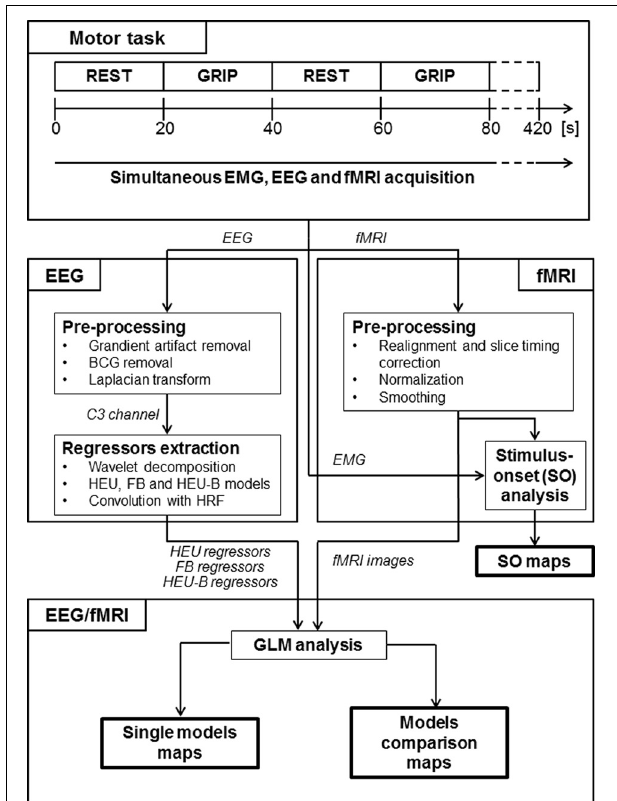
FIGURE 1 | Experimental protocol and data analysis pipeline. This figure gives a schematic overview of the task, the different steps in EEG-fMRI processing and the outcome of the analysis (see Methods section for details). “Motor task” block: the motor task consists in a block-designed right hand grip. “EEG” block: gradient and BCG artifacts were removed from the EEG data; a surface Laplacian estimation was applied; EEG from channel C3 was decomposed using wavelet transform and HEU, FB and HEU-B regressors were estimated. “fMRI” block: the EPI images were motion and slice timing corrected, normalized and spatially smoothed; regressors modeling motor task were created and a stimulus-onset group map was obtained through GLM analysis. “EEG/fMRI” block: the HEU, FB, and HEU-B regressors were used to model EEG-fMRI relationships in separate design matrices and three single model maps (one per model) were obtained; finally, a direct comparison was performed by including regressors from different models in the same design matrix, thus obtaining model comparison